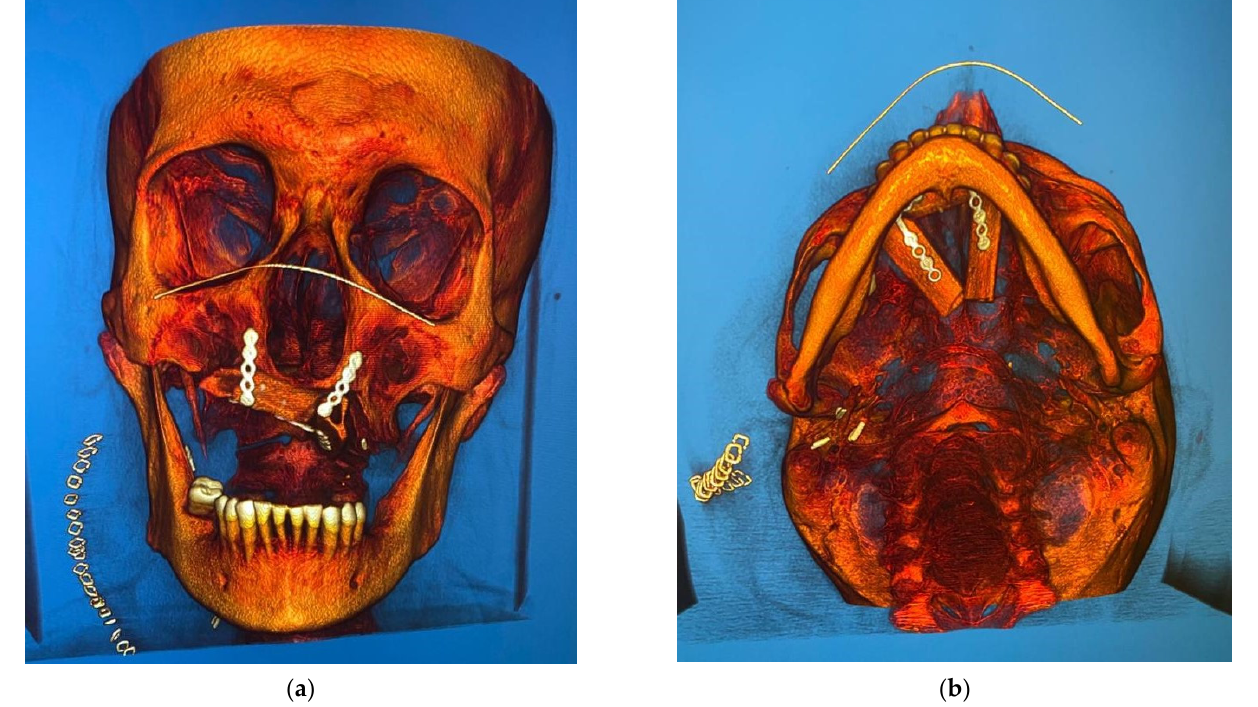
Figure 5. CBCT reconstruction after surgery ( a -frontal view; b -coronal view). The CBCT was performed the day after surgery.